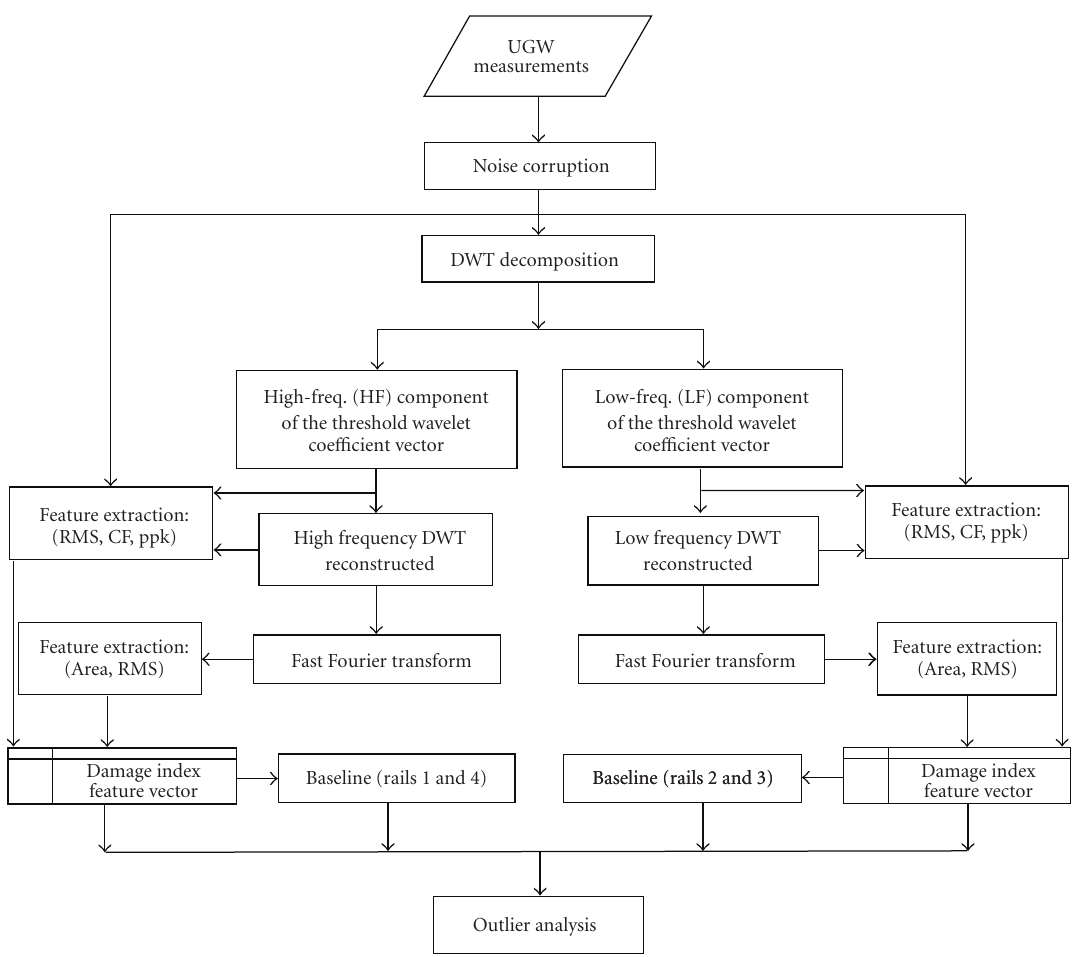
Figure 4: Flowchart of the automatic damage detection algorithm based on discrete wavelet transform, feature extraction, and outlier